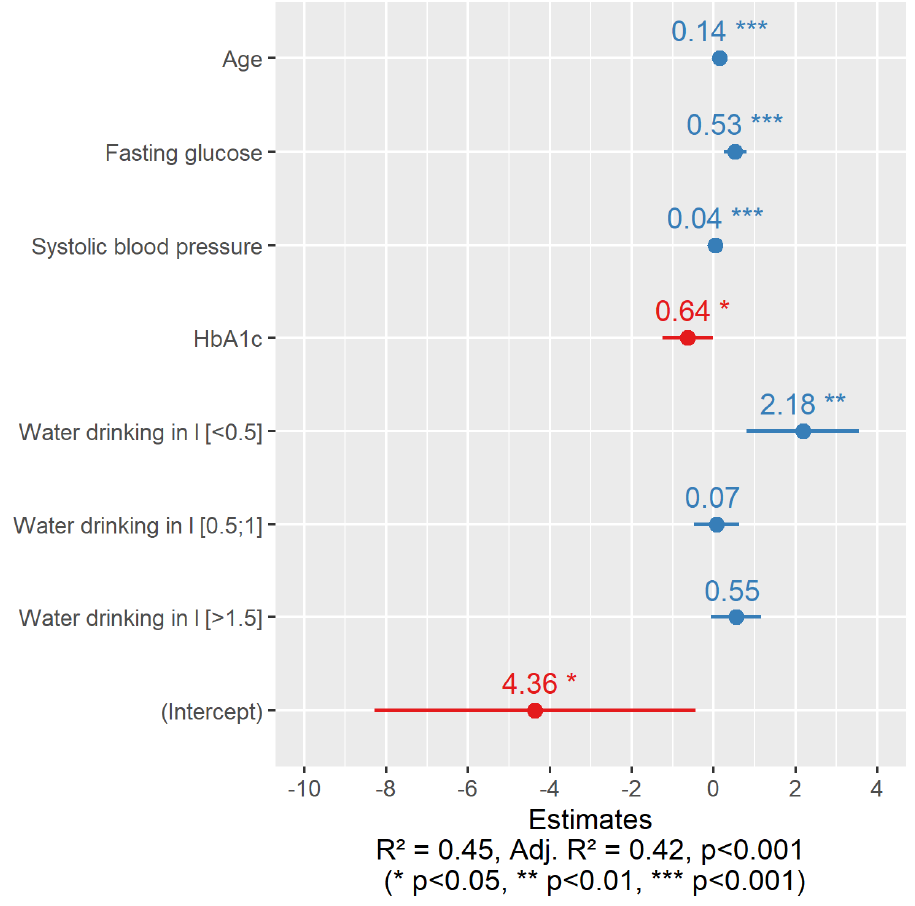
Figure 3. Coefficients of the linear logistic regression for cfPWV in women with increased sUA levels (N = 131). The positive values of the coefficients are presented in blue, and the negative values of the coefficients are presented in red.